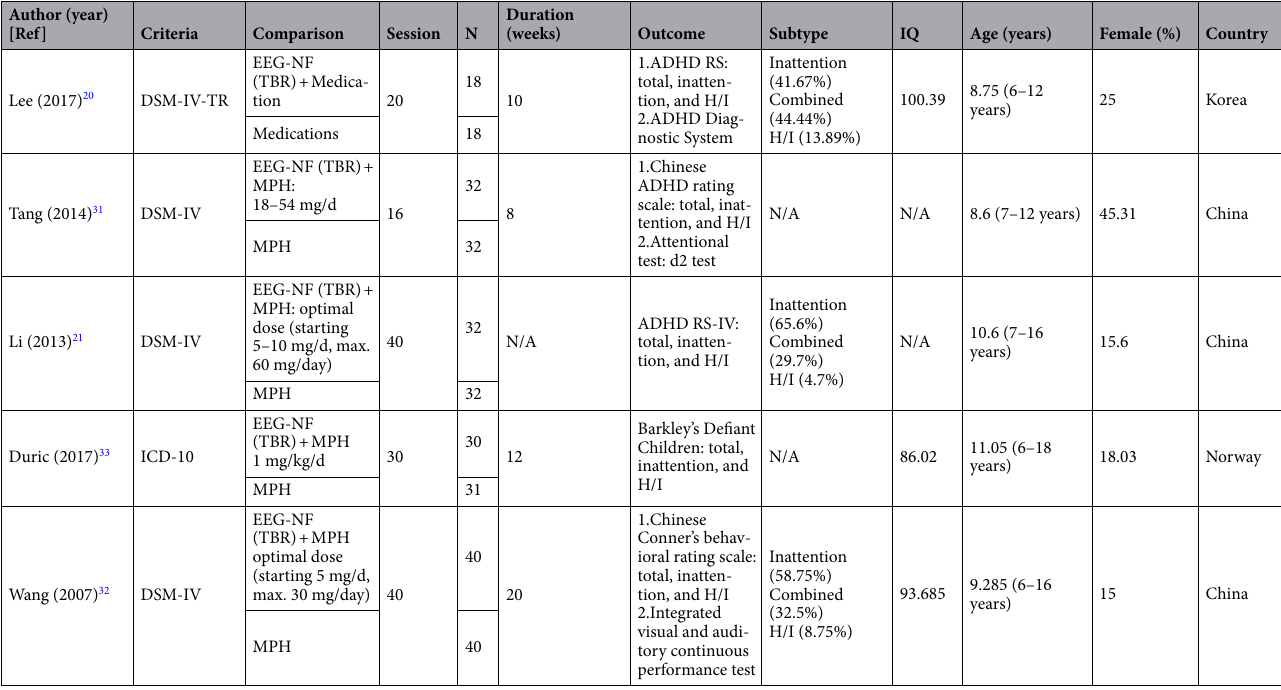
Table 1. Summary of characteristics of included studies in the current meta-analysis. ADHD-RS ADHD Rating Scale, ADHD-RS-IV ADHD Rating Scale-IV, d day, DSM-IV diagnostic and statistical manual of mental disorders, fourth edition, DSM-IV-TR diagnostic and statistical manual of mental disorders, fourth edition, text revision, EEG-NF electroencephalographic biofeedback, H/I hyperactivity/impulsivity, ICD-10 International Classification of Diseases, 10th Revision, IQ Intelligence Quotient, MPH methylphenidate, N number, N/A not available, TBR theta/beta